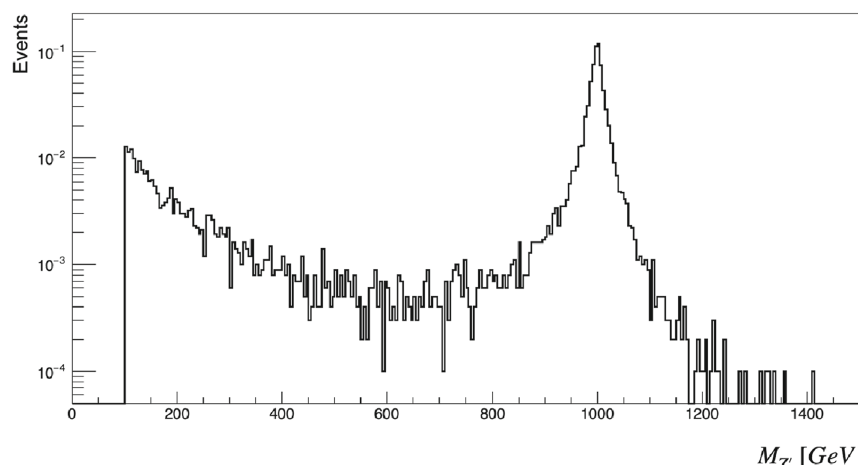
Fig. 24 Distribution of the Z (cid:7) mediator mass from dark quarks (nominal value set in the simulation m Z (cid:7) = 1 TeV and (cid:15) = 20 Z (cid:7)